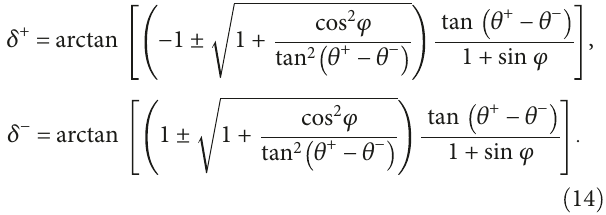
Figure 4: Cauchy boundary problem considering the impact of the ground water table.